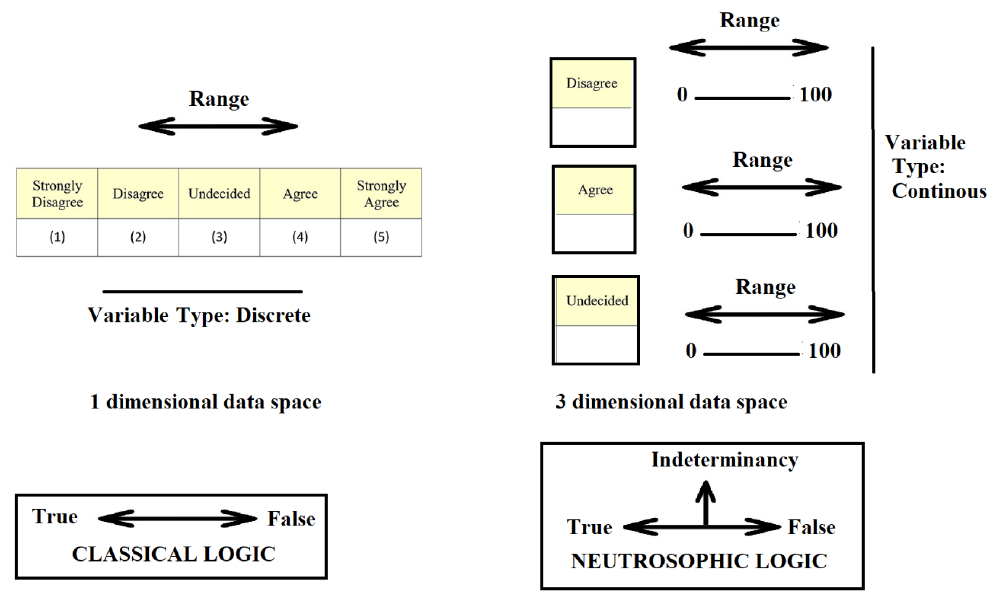
Fig. 5. Data space of classical Likert-type scale, neutrosophic